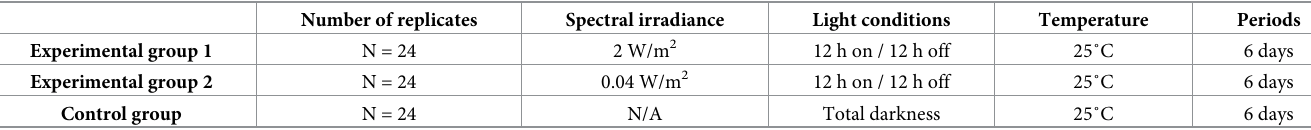
Table 1. Experimental